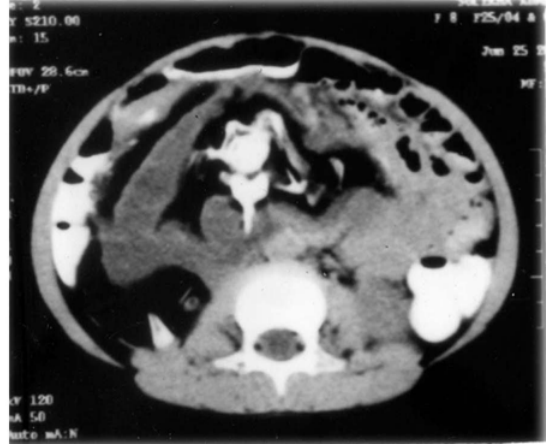
FIGURE 2. Transverse CT scan of upper abdomen of the girl showing soft tissue, fat and bony elements including vertebral body and long